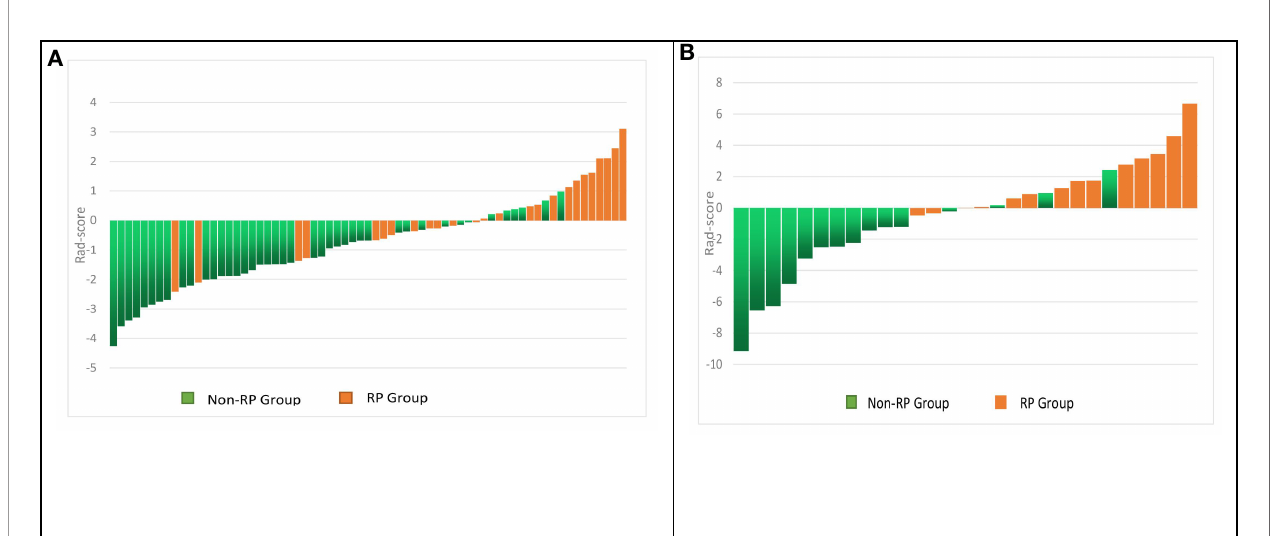
FIGURE 4 | Rad-score for each patient in the primary and validation cohorts. Green bars show scores for patients without RP, and orange bars show scores for those with RP (A, B) .